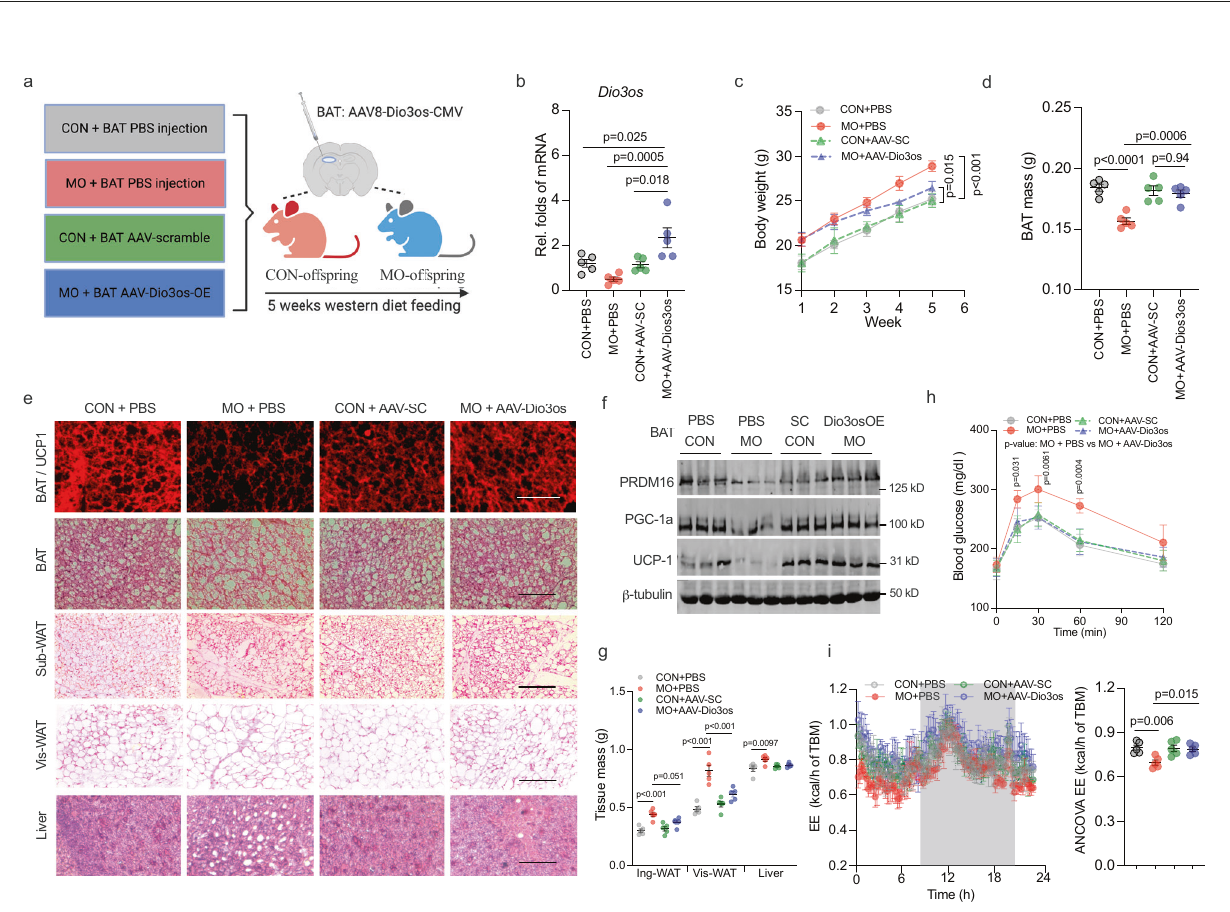
Fig. 5 In vivo Dio3os expression activates brown adipogenesis and thermogenesis, improving energy expenditure and glucose tolerance. a C57BL/6J female mice at 7 days of age ( n = 5) were injected with adeno-associated virus type 8 (AAV8)- Dio3os -CMV or AAV8-scramble-CMV (1.5 × 10 11 vg per mouse) into interscapular brown fat (BAT) at 22 °C. Mice were euthanized 5 weeks post-injection at 22 °C. b , c Body weight ( b ) and BAT mass ( c ) after AAV injections ( n = 5). d mRNA expression of Dio3os and Dio3 in interscapular BAT at 5 weeks post-injection ( n = 5). e T3 concentration ( e ) in BAT ( n = 5). f , g Immunoblotting measuring protein contents of D3, PRDM16, PGC-1a, and UCP-1 in BAT ( n = 5). β -tubulin was as a loading control. h H&E staining and immunohistochemical staining of mitochondria (mito-tracker, green) and UCP-1 (red) in BAT ( n = 5). Scale bar 150 µ m (H&E) and 250 µ m (immunostaining). i Heatmap displaying mRNA expression of brown adipogenic and mitochondrial biogenic genes in BAT ( n = 5). j PRDM16 immunoprecipitation in measuring PGC-1a and CtBP1 complex in isolated BAT-SVFs. PRDM16, PGC-1a, and CtBP1 were detected by immunoblotting. IgG was used as a negative control ( n = 5). k , l Oxygen consumption ( k ) and energy expenditure ( l ) of mice at 5-week post AAV injections ( n = 5). Metabolic data were regressed to body mass according to guidelines of ANCOVA NIDDK MCCP tool. m , n Mice were exposed to 4 °C and surface body temperature ( m ) and core body temperature (24 h in cold) ( n ) ( n = 5). Data are presented as mean ± s.e.m. Unpaired Student t test with two-tailed distribution was used for data analyses.